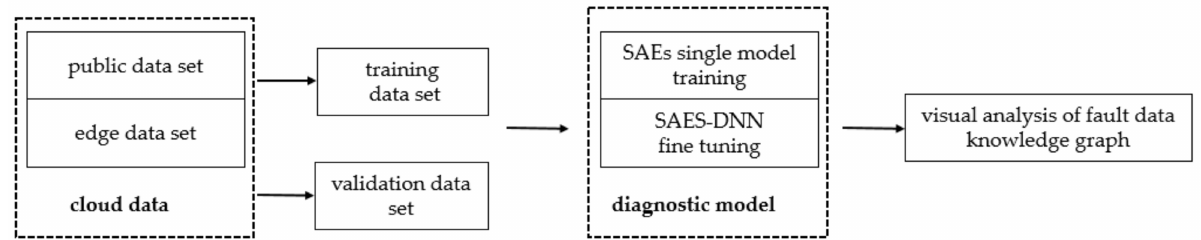
Figure 2. The training and updating process of the cloud diagnostic model. The process includes three parts: cloud data partition, fault diagnosis model training and visual